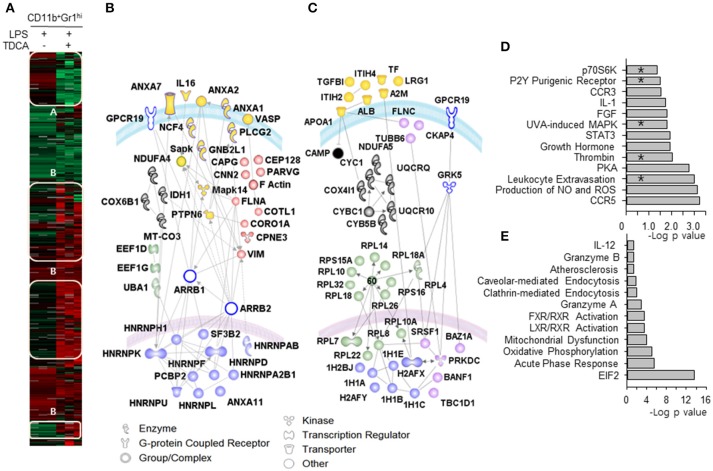
Proteomic differences between MDSCLT and MDSCL cells. (A) The heat map indicates two distinct proteome clusters that were down-regulated in MDSCLT (cluster A) and up-regulated in MDSCLT (cluster B) compared with MDSCL cells. Protein lysates were pooled from cells obtained by 3 independent sorting for each group. n = 3 mice in each independent sorting. (B) The proteins in cluster A were further sub-clustered based on their common functions. The red symbols represent molecules that play roles in cellular trafficking. Blue symbols (alternative splicing), green symbols (protein metabolism), gray symbols (mitochondrial oxidative phosphorylation) and yellow symbols (pro-inflammatory signaling/adhesion/ cytokine molecules) were used to denote each sub-cluster. (C) The proteins in cluster B were further sub-clustered as (B). The pink symbols in the nucleus represent molecules that are potentially associated with the cell cycle and differentiation. The blue symbols in the nucleus represent histones for chromatin remodeling. The green symbols (ribosomal proteins), cytosolic pink symbols (cytoskeletal proteins), gray symbols (mitochondrial respiratory chain) and yellow symbols (acute phase response proteins) were color-coded based on their functions listed in the database of Ingenuity Pathway Analysis (IPA®, QIAGEN). Open symbols are molecules predicted by IPA® that were not observed in the experiments. The gray lines represent potential interactions between the molecules predicted by IPA®. The curved blue lines and pink lines represent the cytoplasmic and nuclear membranes, respectively. Canonical signaling pathways for up-regulated proteins (D) and down-regulated proteins (E) were analyzed. *denotes signaling pathways overlapped with the microarray analysis. –Log (p-value) was calculated using the right-tailed Fisher's exact test to measure the likelihood that the association between a set of genes and pathway was due to random chance. Pathways with p < 0.05 are shown.